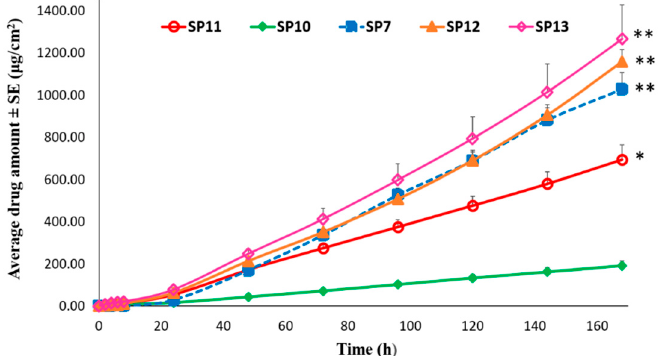
Figure 9. Effect of concentration of TAF in the silicone-based suspension patches on its permeation through human epidermis. * represents significant difference between 5 and 10% patch. ** represents significant difference as compared to 5 and 10% patch, ANOVA one-way test ( p < 0.05). SP7: Silicone-based 15% TAF patch. SP10: Silicone-based 5% TAF patch. SP11: Silicone-based 10% TAF patch. SP12: Silicone-based 20% TAF patch. SP13: Silicone-based 25% TAF patch.